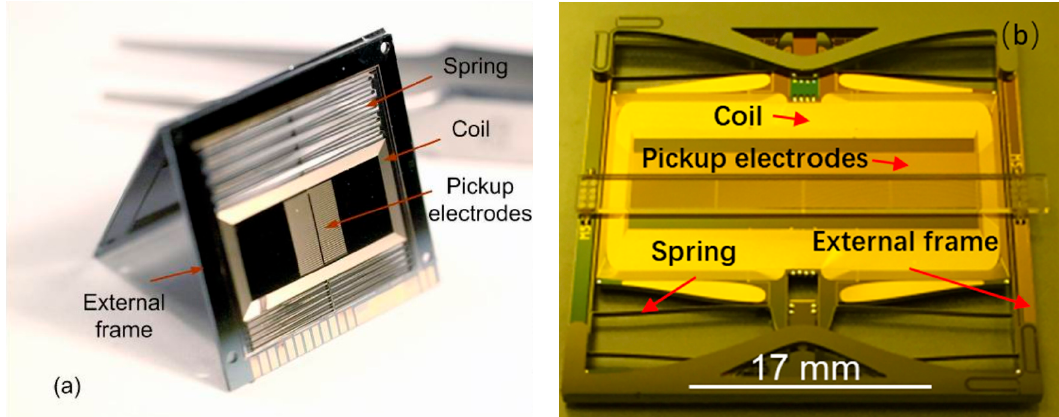
Figure 7. Photographs of the first version of MEMS accelerometers developed by Pike et al. at Imperial